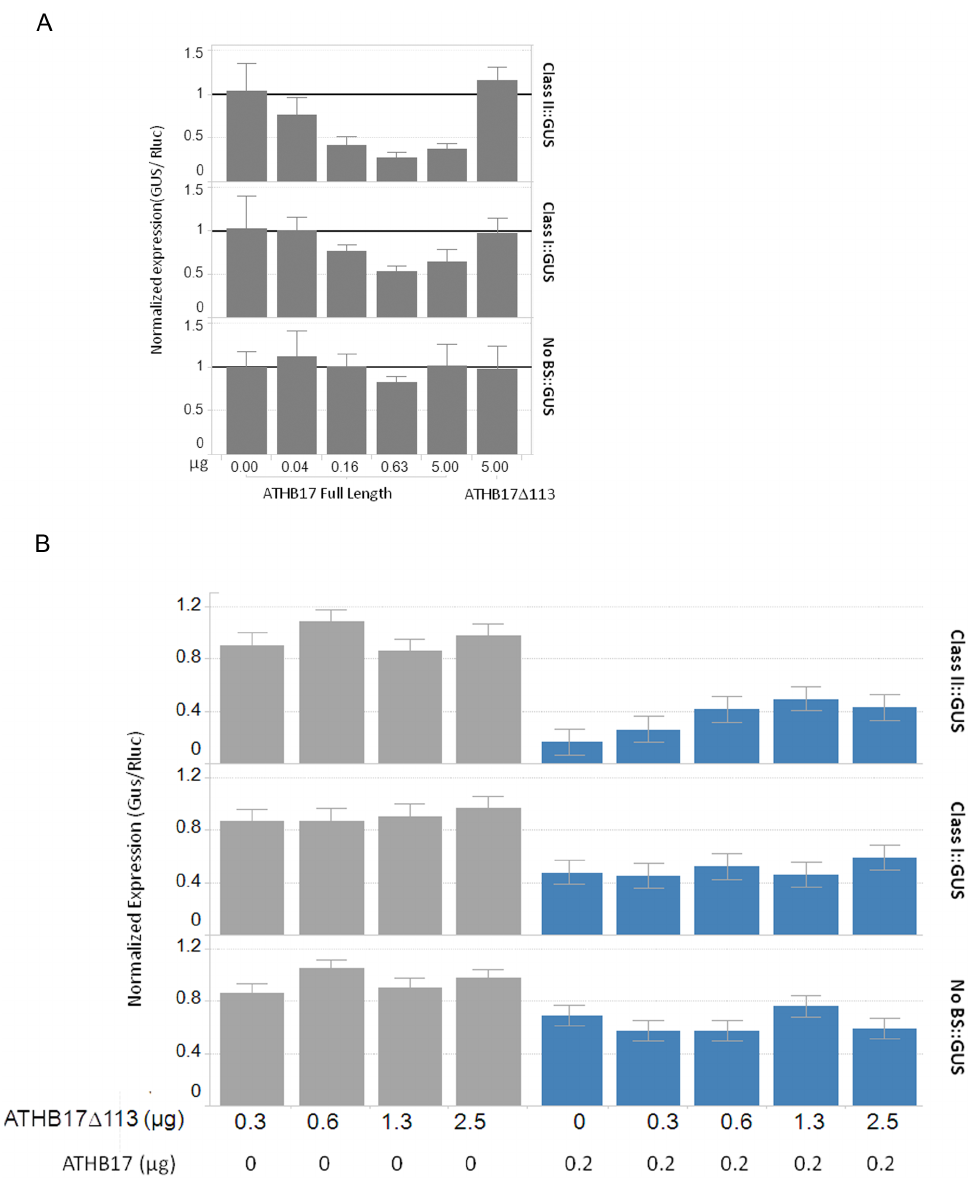
Figure 7. Full- length ATHB17 protein functions as transcriptional repressor and ATHB17 D 113 can relieve repression caused by full- length ATHB17 protein. Maize mesophyll protoplasts were transformed (A) with 4 m g cells of reporter (Class II::GUS, Class I::GUS or No BS::GUS) and 0–5 m g cells of effector (Full-length ATHB17) or 5 m g of ATHB17 D 113 and Renilla luciferase (B) with 4 m g reporter (Class II::GUS, Class I::GUS or No BS::GUS), 0–5 m g ATHB17 D 113, and 0 (grey bars) or 0.2 m g (blue bars) of ATHB17 full length. DNA amounts are per 320,000 cells. After 18 h, cells were assayed for GUS and luciferase expression. GUS values were divided by luciferase internal control values for each well and normalized to respective GFP samples. Bars are means and error bars represent 1 SD.